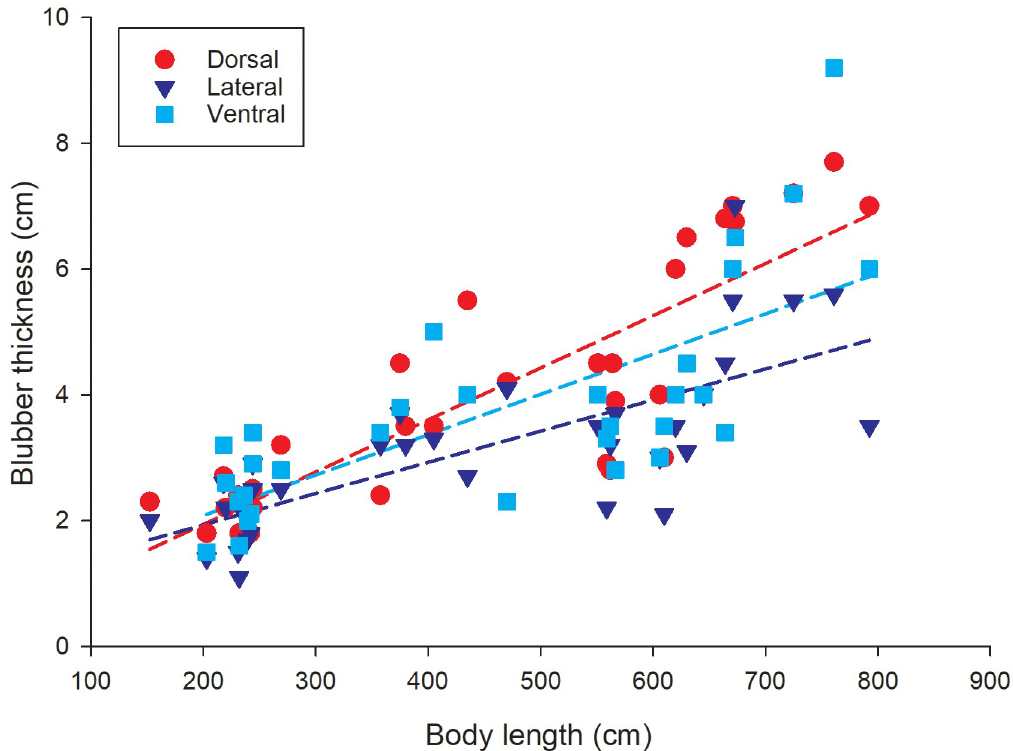
Fig 9. Blubber thickness in relation to body length. Blubber thickness measurements at the three sites along the anterior dorsal fin insertion girth measurement line are presented. Least-squares linear regressions are also shown (dashed lines): dorsal blubber thickness (red circles) = 0.3 + 0.008 body length (F = 86.4, R 2 = 0.7, p < 0.001, n = 33 individuals), lateral blubber thickness (dark blue triangles) = 0.9 + 0.005 body length (F = 36.8, R 2 = 0.5, p < 0.001, n = 33 individuals), ventral blubber thickness (light blue squares) = 0.8 + 0.006 body length (F = 34.1, R 2 = 0.5, p < 0.001, n = 31